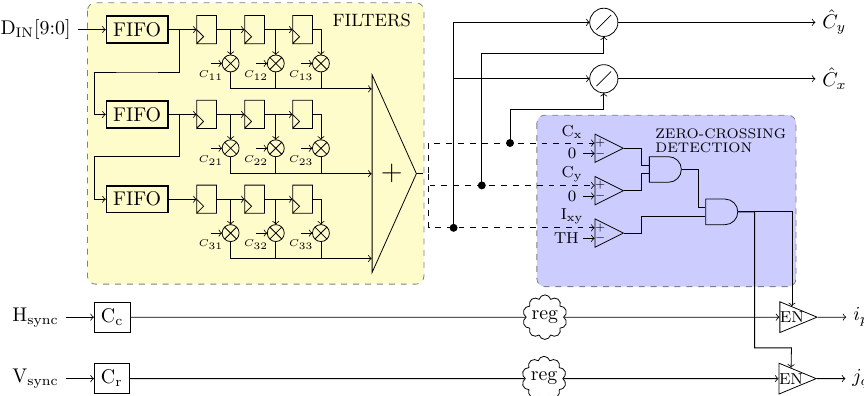
Figure 4. Diagram for the implementation of SCoG module used for calculate integer pixel centroid values. Depending on the coefficient values C , the numerators and denominators in Equation (3) are calculated from the FILTERS circuit.